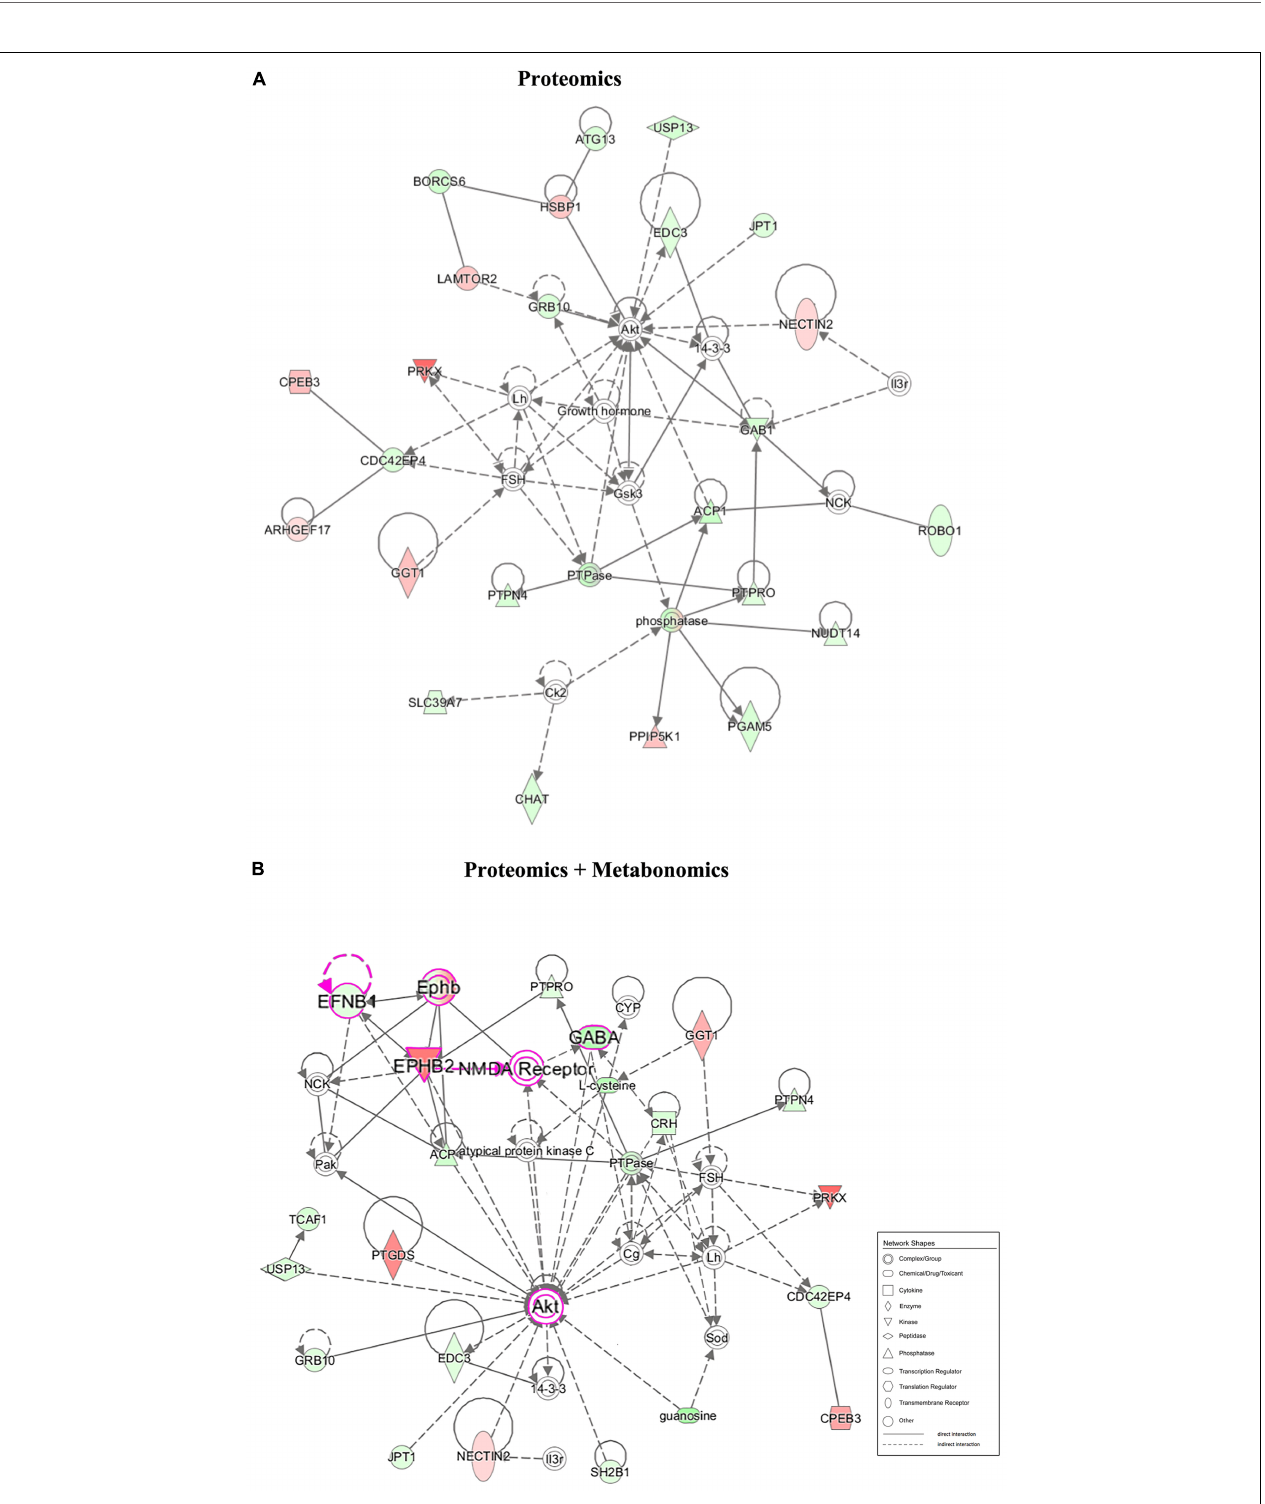
Frontiers in Neuroscience |